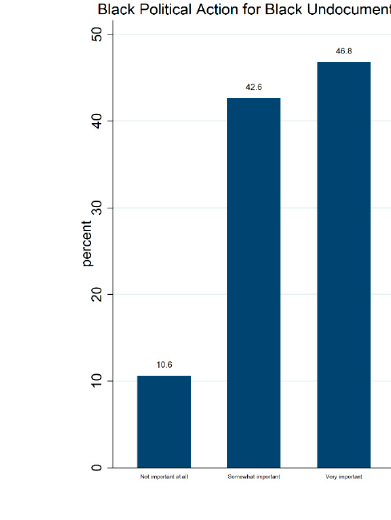
Table 2. Odds ratios from the ordinal logistic models of support for deporting immigrants who break the law by anti-Latino perceptions, demographics, and registration status.